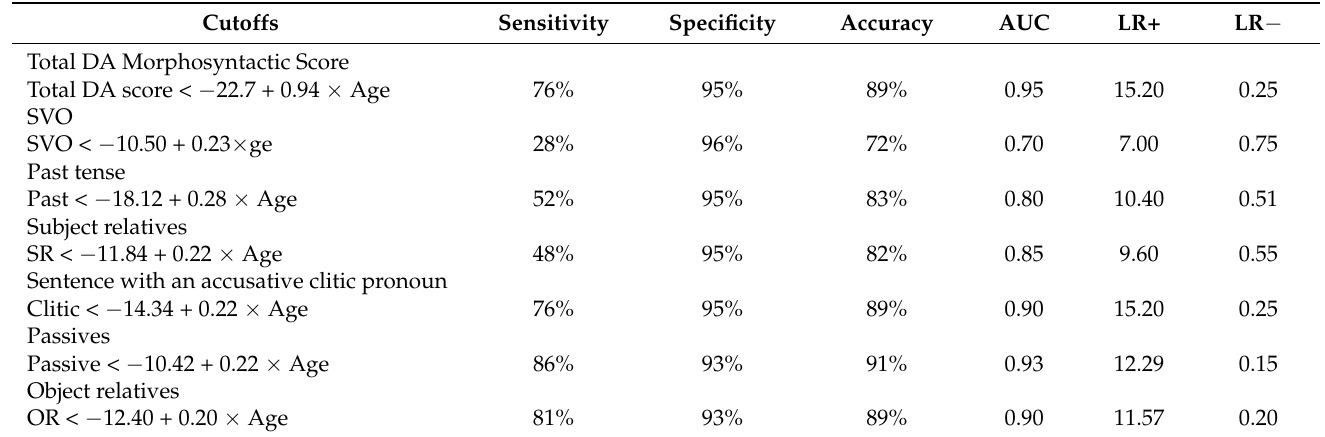
Table 9. Classification accuracy of DLD participants with morphosyntactic deficiency versus TD children by cutoff